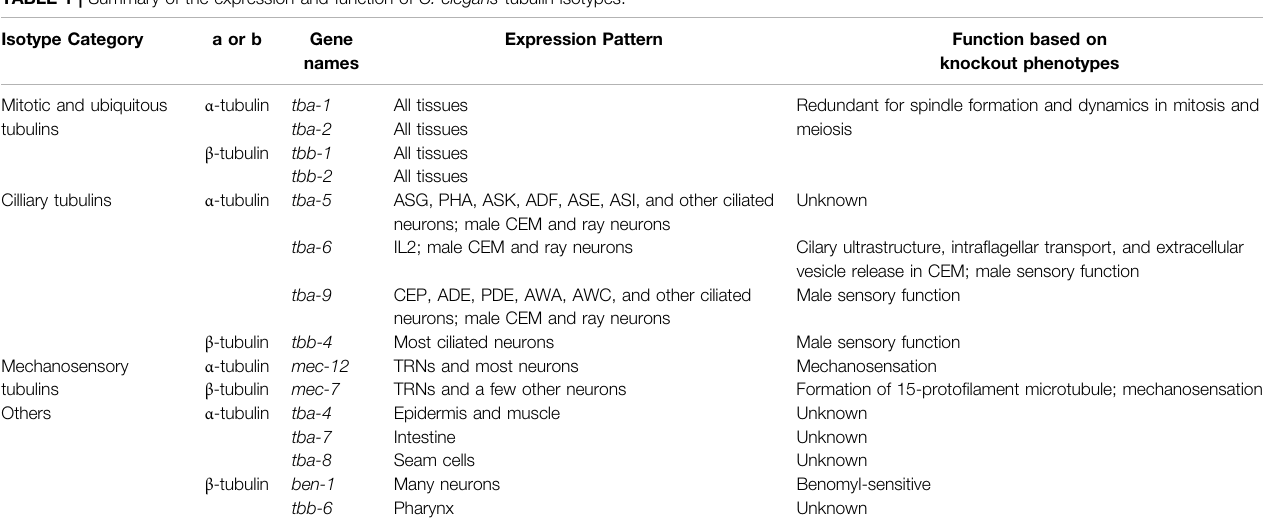
TABLE 1 | Summary of the expression and function of C. elegans tubulin